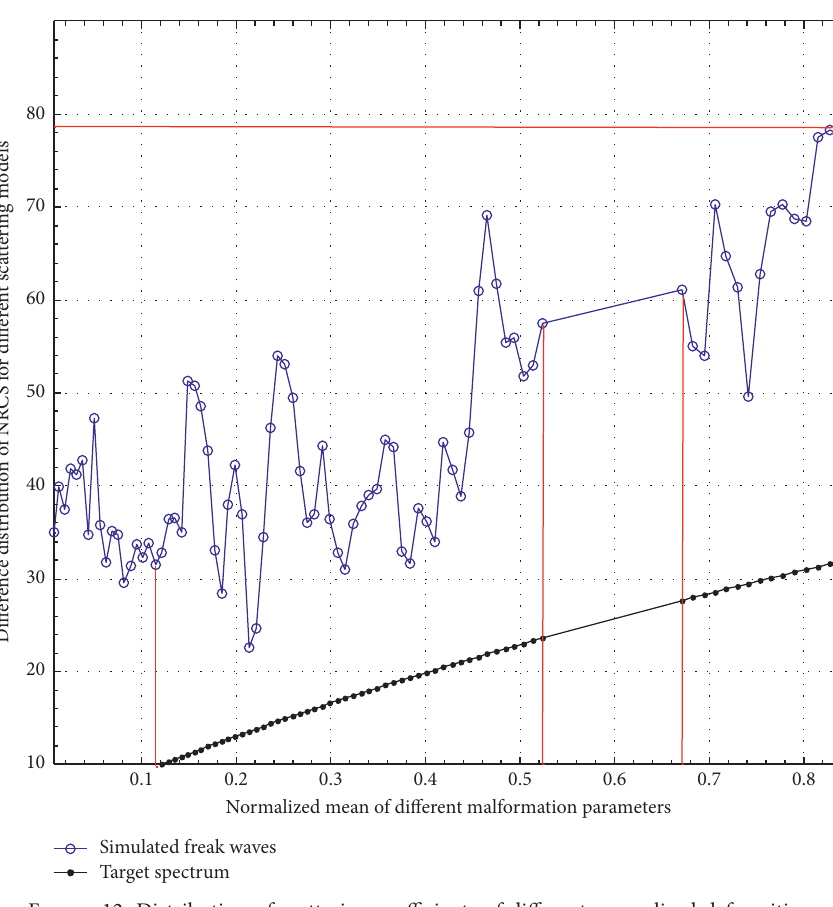
Figure 12: Distribution of scattering coefficients of different normalized deformities.